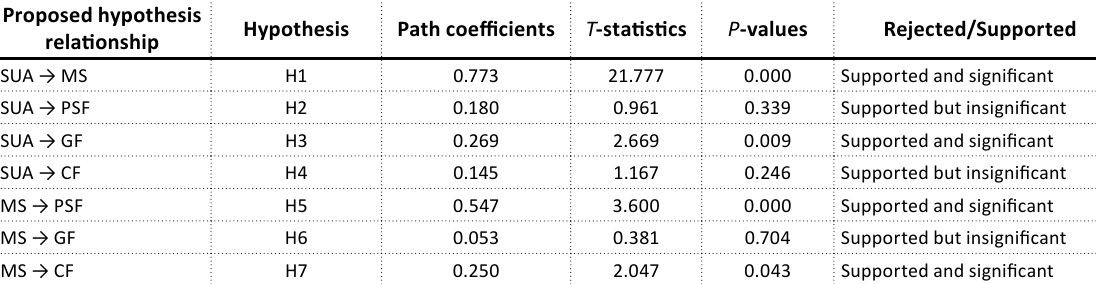
Table 7. Hypothesis test results